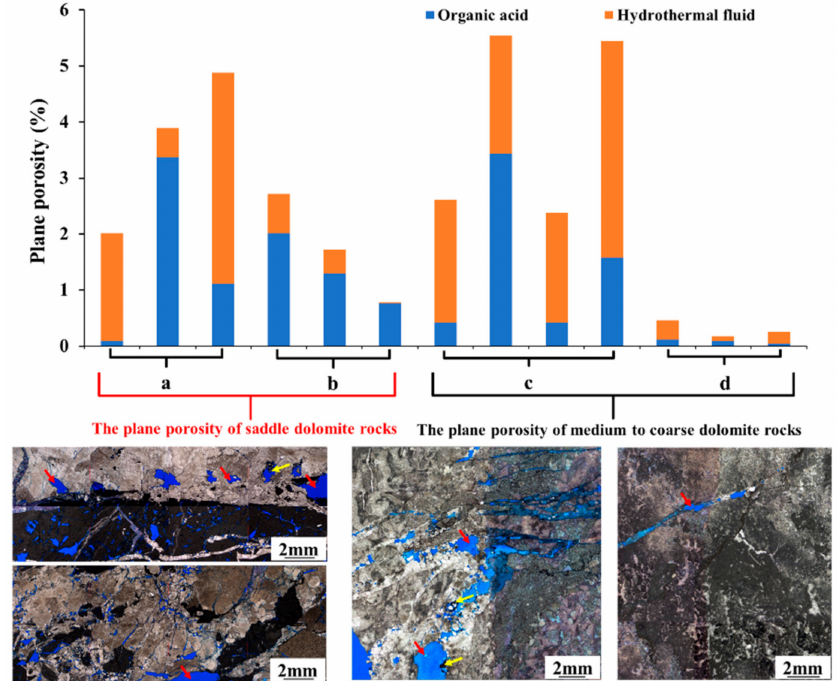
Figure 12. The total plane porosity of all kinds of dolomite cements with different textures and the rate of contribution of different fluids to the percent of area pores. ( a ) The contribution of dissolution to the plane porosity of the rocks that developed saddle dolomite and its microscopic characteristics when dissolution is strong; ( b ) when the dissolution is not obvious, the contribution of dissolution to the plane porosity of the rocks developed saddle dolomite and its microscopic characteristics; ( c ) the rock developed with a high-density fracture area, and the image shows the contribution of dissolution to the plane porosity of the rocks; ( d ) the rock developed a low-density fracture area, and the image shows the contribution of dissolution to the plane porosity of the rocks; red arrow: dissolution vugs; yellow arrow: residual bitumen.